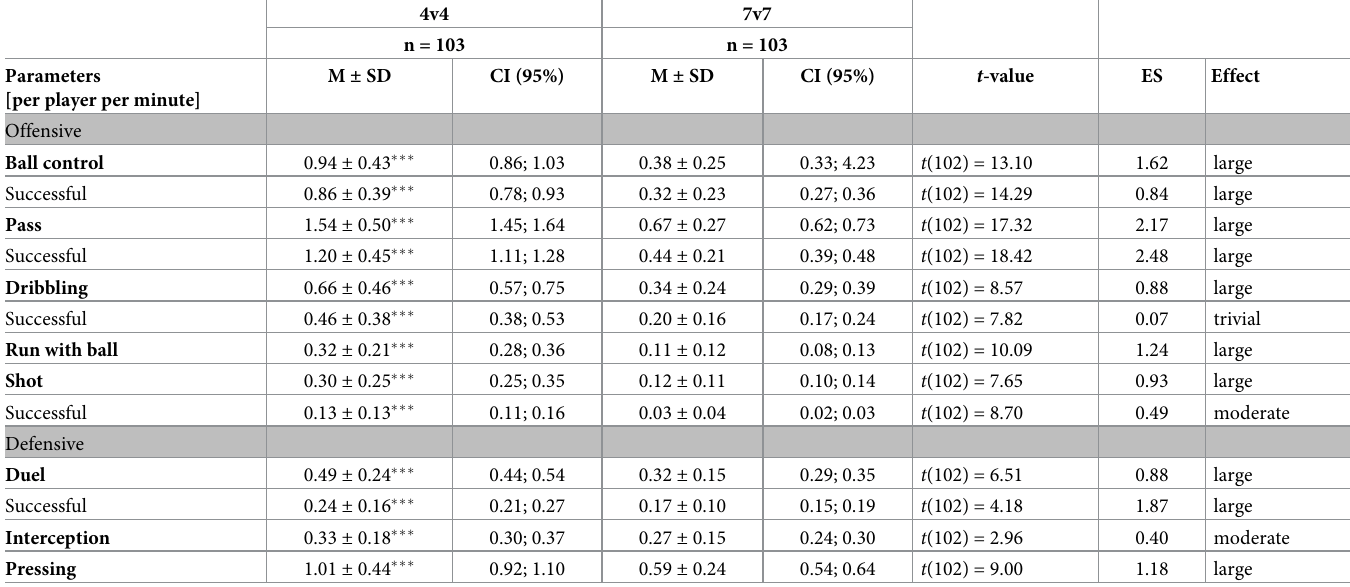
Table 1. Quantity and quality of offensive and defensive technical-tactical parameters in the 4v4 and 7v7 match format per player per